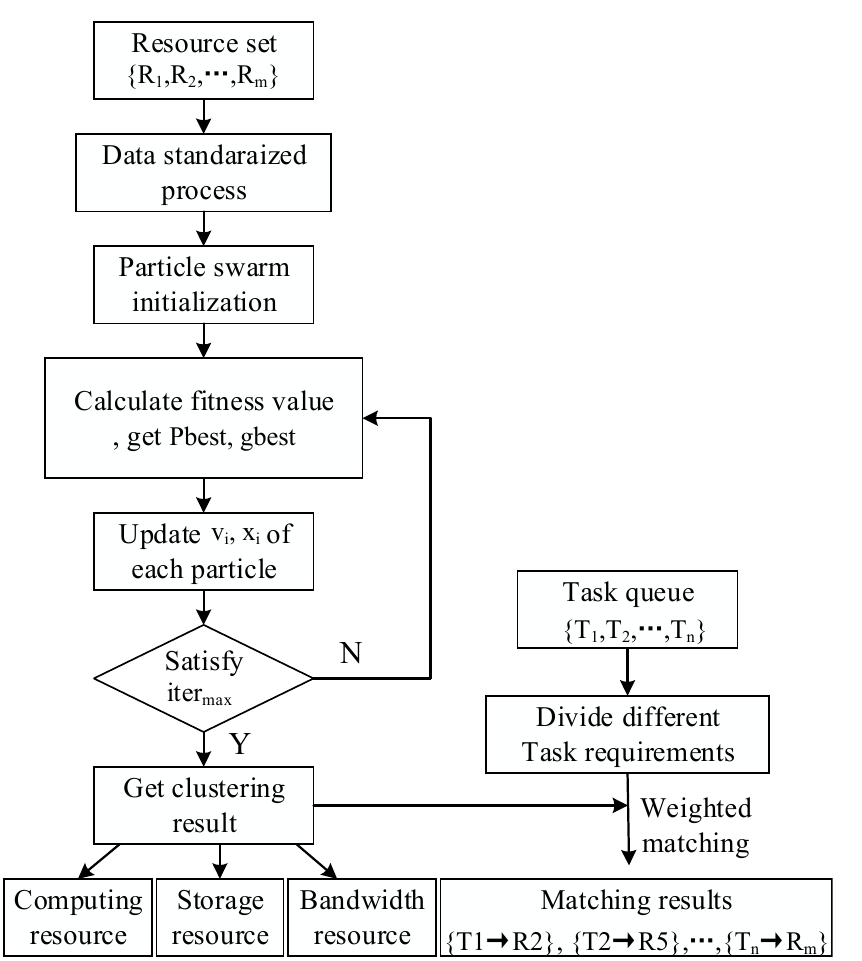
Figure 4. Resource clustering and scheduling process.